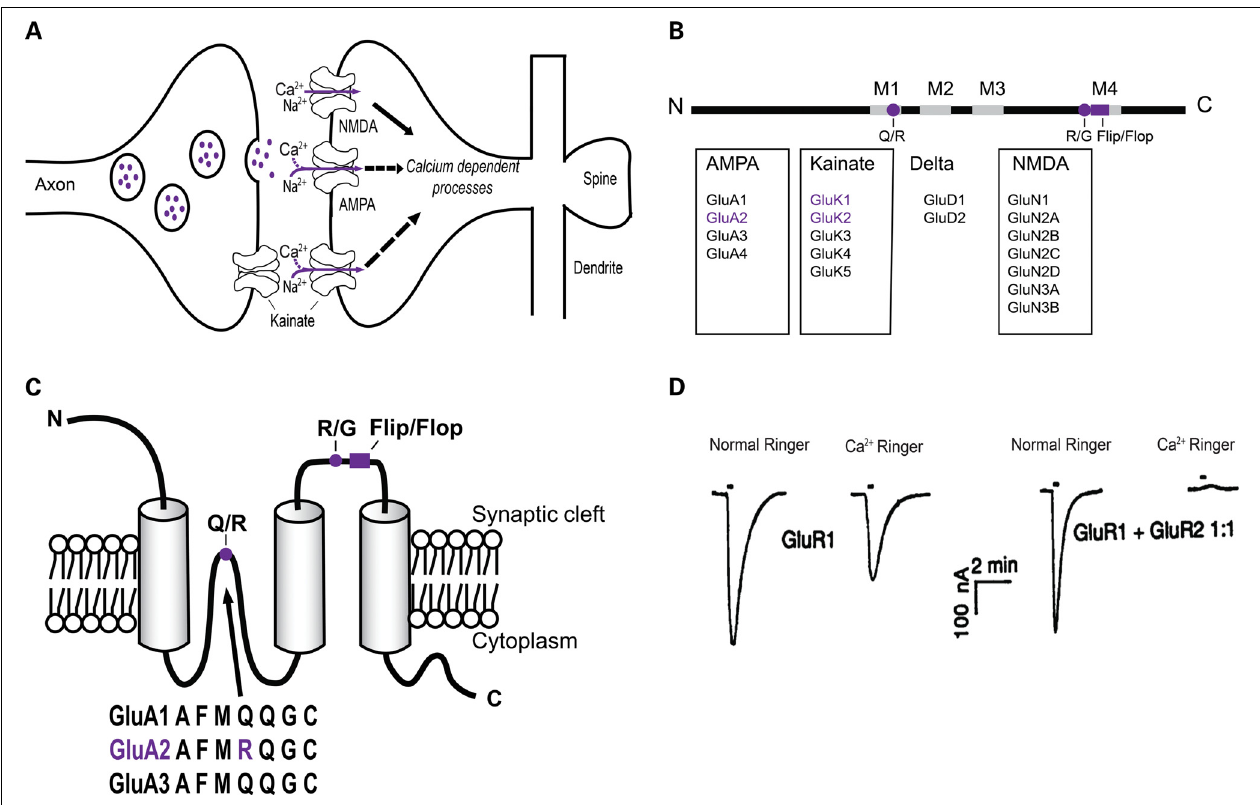
FIGURE 1 | Schematic view ofAMPA, NMDA, and KA receptors within the postsynaptic density and theAMPA receptor structure. (A) Glutamate in the synaptic cleft can act on ionotropic receptors including AMPA, NMDA, and KA receptors causing a Ca 2 + influx leading to intracellular signaling cascades. (B) Representation of the primary structure of AMPA receptor subunits with N- and C-terminals, four membranes, M1–M4 (gray boxes), two editing sites, Q/R and R/G (violet dots), and alternate spliced flip/flop site (violet box). A summary of glutamate receptors and their subunits are also shown. Subunits shown in violet are subunits that undergo RNA editing at the Q/R site. (C) Topology (secondary structure) of the GluA2 subunit with three transmembrane domains.The Q/R RNA editing site controls